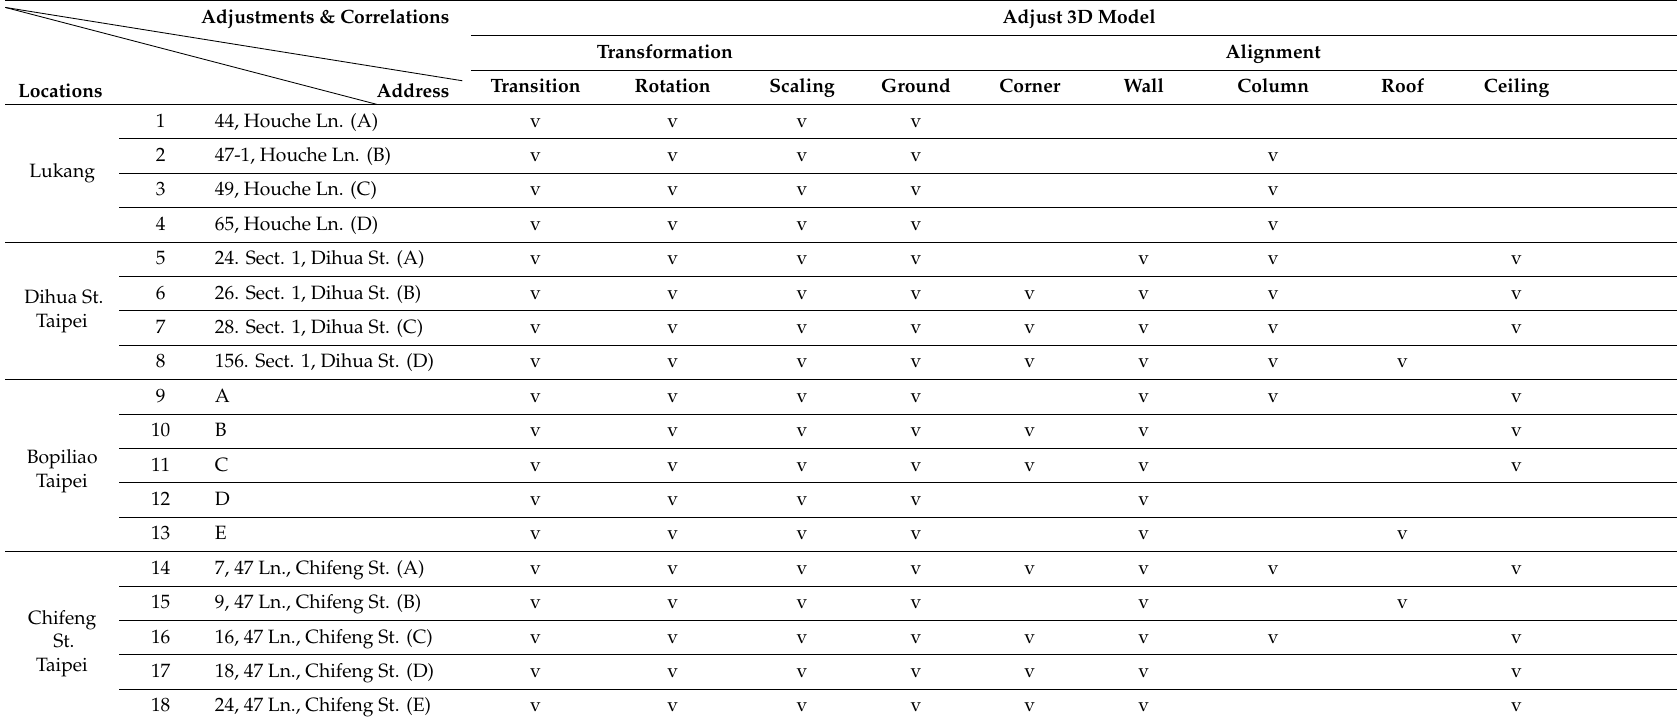
Table 1. The reviewing record of situated